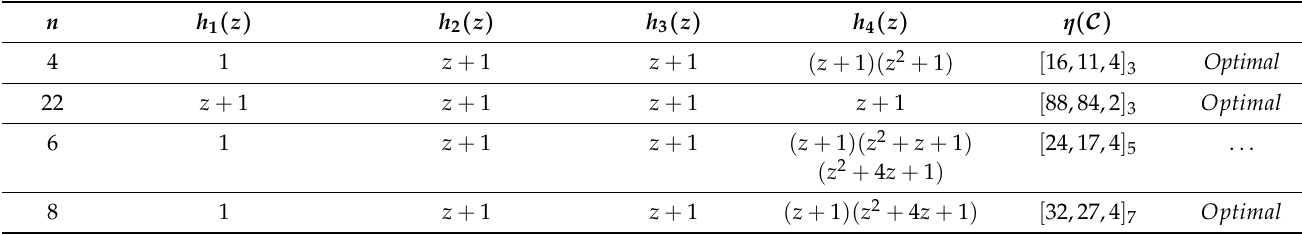
Table 3. Gray images of LCD codes of length n over R